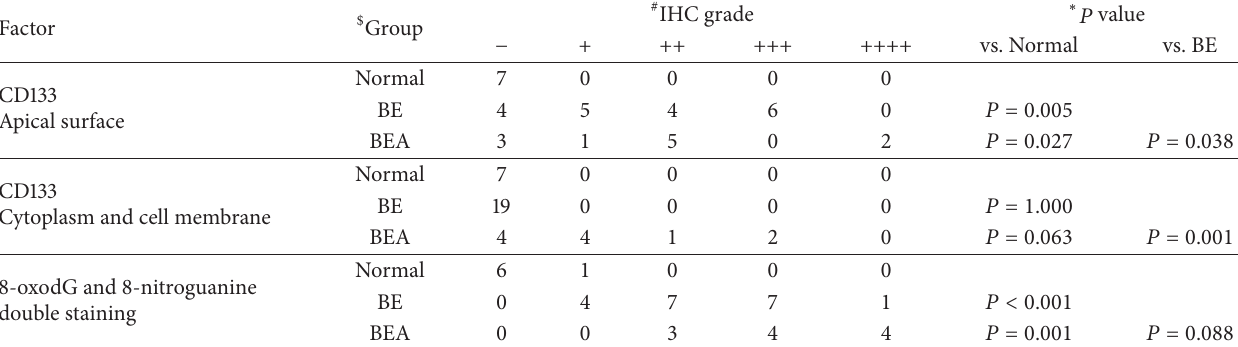
Table 1: Immunoreactivity grading of CD133 among normal esophagus, Barrett’s esophagus, and Barrett’s adenocarcinoma tissues. Factor